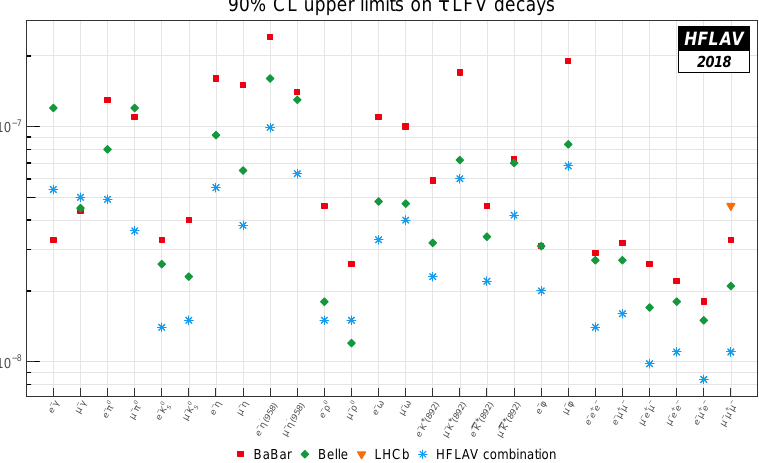
Figure 20. Tau lepton-flavor-violating branching fraction upper limits combinations summary plot. For each channel, we report the HFLAV combined limit and the experimental published limits. In some cases, the combined limit is weaker than the limit published by a single experiment. This arises since the CLs method used in the combination can be more conservative compared to other legitimate methods, especially when the number of observed events fluctuates below the expected background